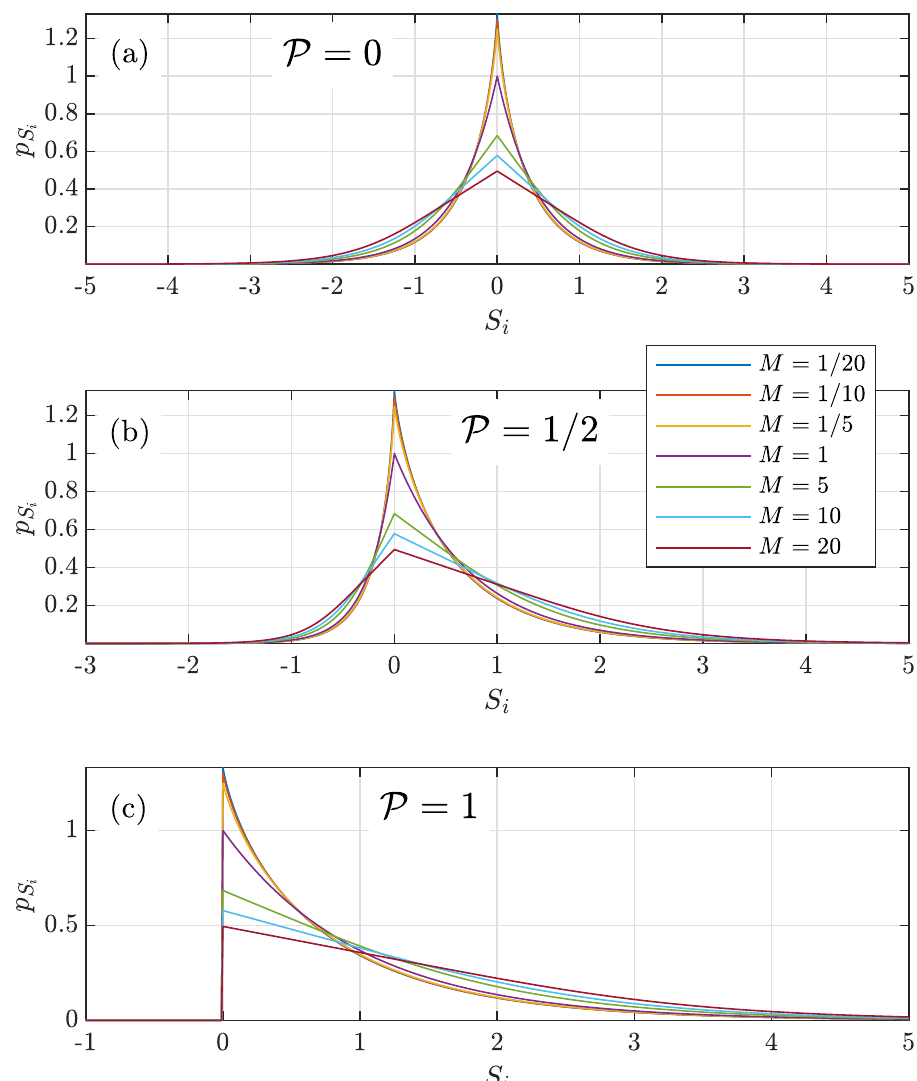
Figure 3. PDF of S i p S [Equation (44)] for various values of M : ( a ) P = 0, ( b ) P = 1/2, and ( c ) P = i